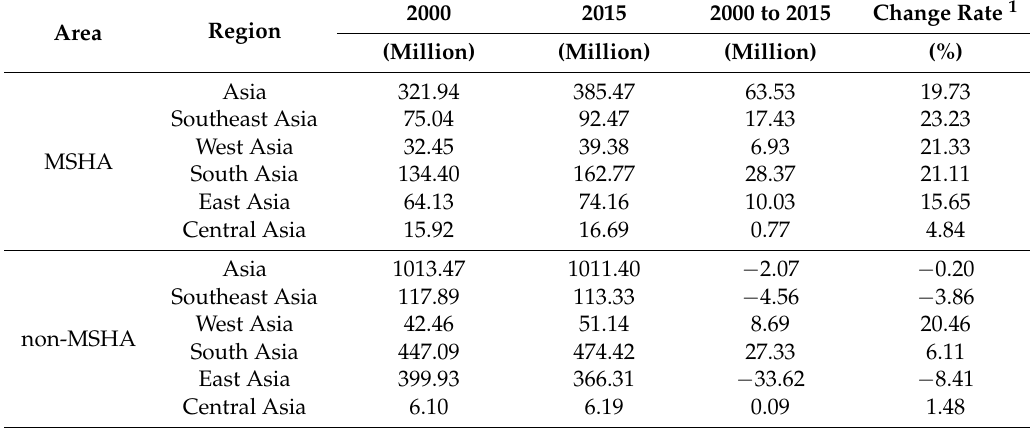
Table 3. Changes in the vulnerable population of Asia from 2000 to